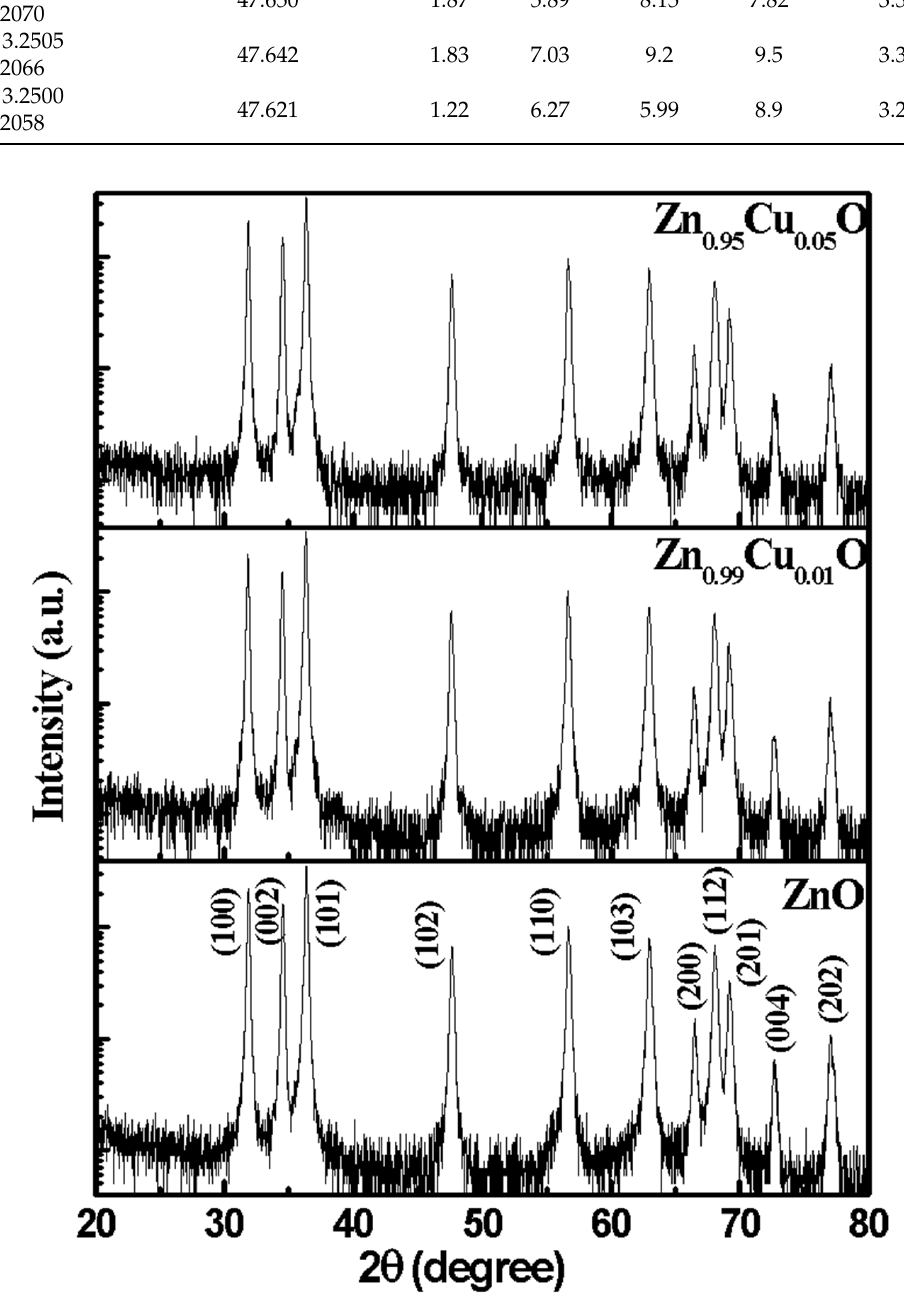
Figure 1. XRD pattern of Cu-doped ZnO